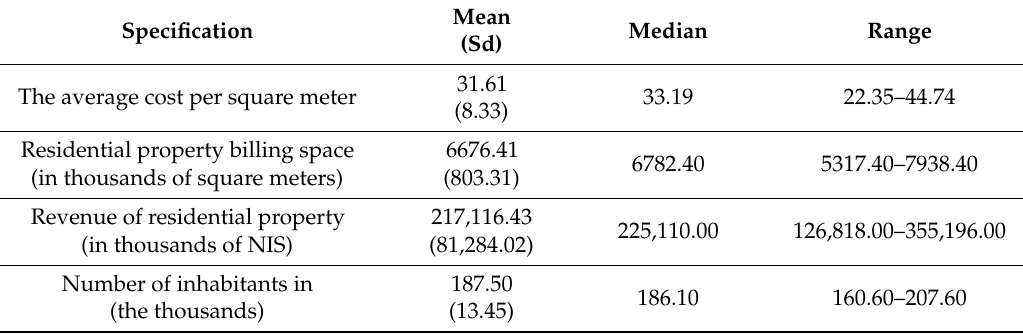
Table 4. Descriptive statistics of the variables for the city of Beersheba.